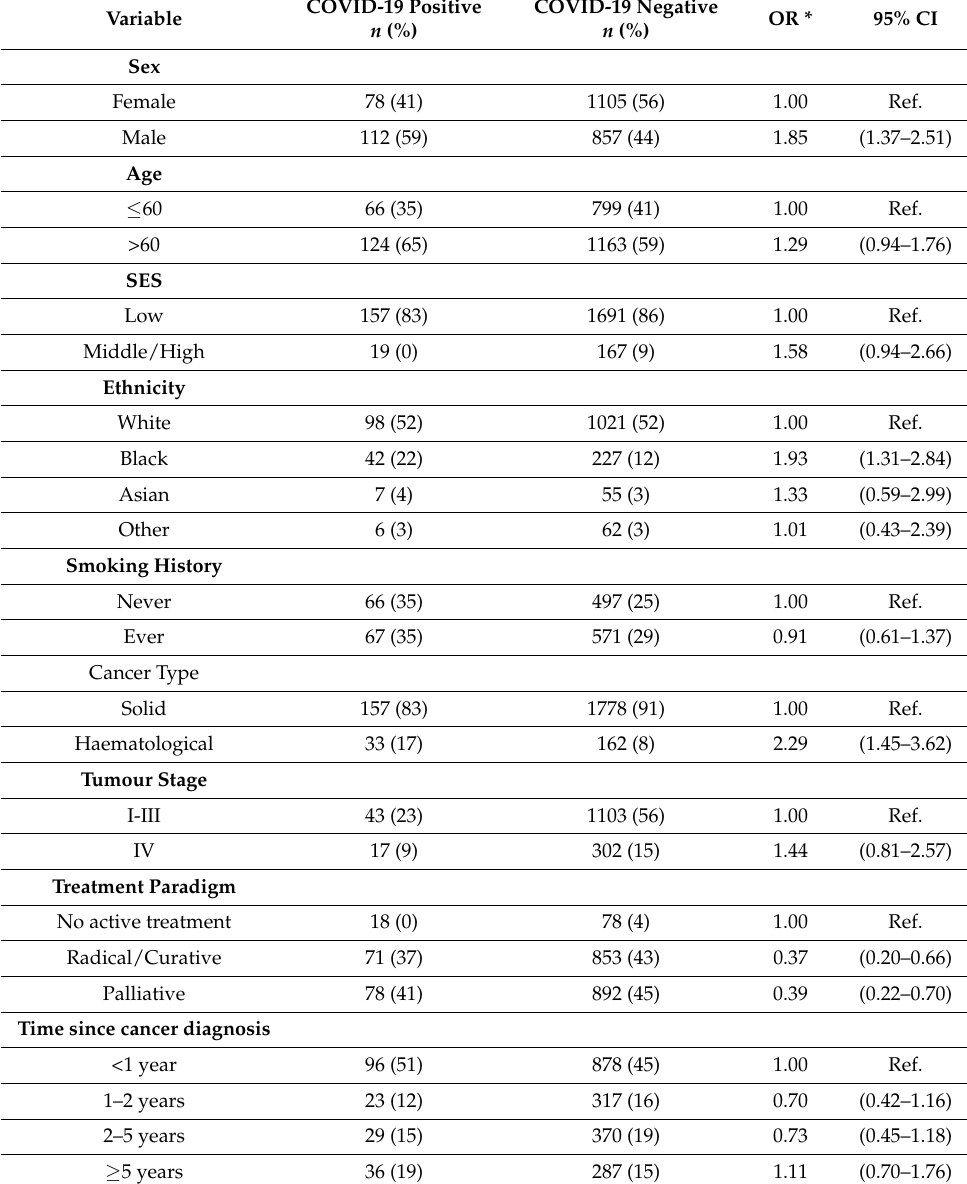
Table 2. Odds ratios and 95% confidence intervals for risk of COVID-19 in cancer